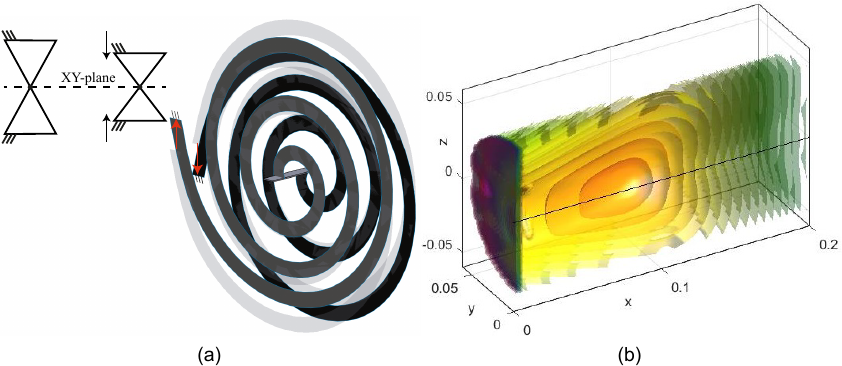
Figure 10. (a) Two mirrored flat in-plane spirals with 0 ◦ material orientation are connected at their endpoints through a shuttle. Subsequently, the clamped outer ends of the spiral are moved apart by 20mm each in the z -direction. (b) In the PEF of the obtained system the “bubble” of lowest energy drifts away from the main plane. Considering symmetry about the main plane, a bi-stable system is